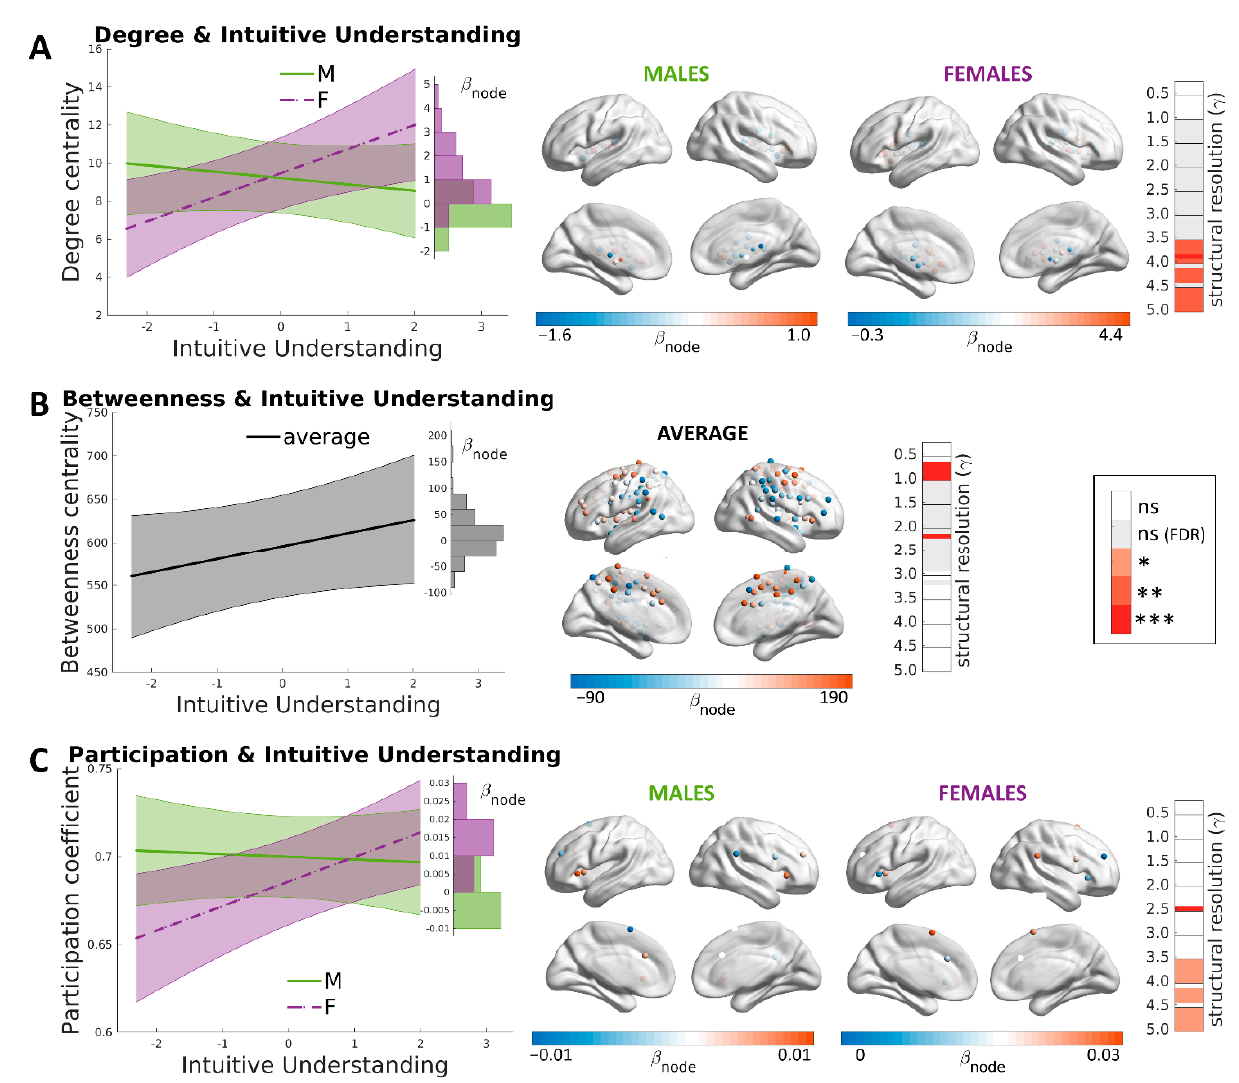
Figure 4. Brain correlates of Intuitive Understanding. ( A ) The association between degree centrality in the subcortical module and intuitive understanding was positive in females (magenta) and absent in males (green), as shown by prediction plots on the left. The middle section of the subfigure shows that the highest contributions to this association were particularly due to caudate and putamen regions. Such association was significant with high values of structural resolution, as shown on the right ( γ > 3.5), since with lower values, subcortical nodes are merged in the same module with cerebellar nodes. ( B ) Betweenness centrality and intuitive understanding were positively associated in a sensorimotor module. The highest associations were in mid-cingulate regions. The result was consistent with low structural resolutions (0.5 < γ < 1.0). ( C ) The association with the participation coefficient of salience nodes was true only in females, and it was true with high values of structural resolutions ( γ > 3.5), which allow smaller modules. Legend for significance with respect to structural resolutions: white = non-significant; gray = non-significant after correction for multiple comparisons; light red * = p < 0.05; medium red ** = p < 0.01; dark red *** = p < 0.005.